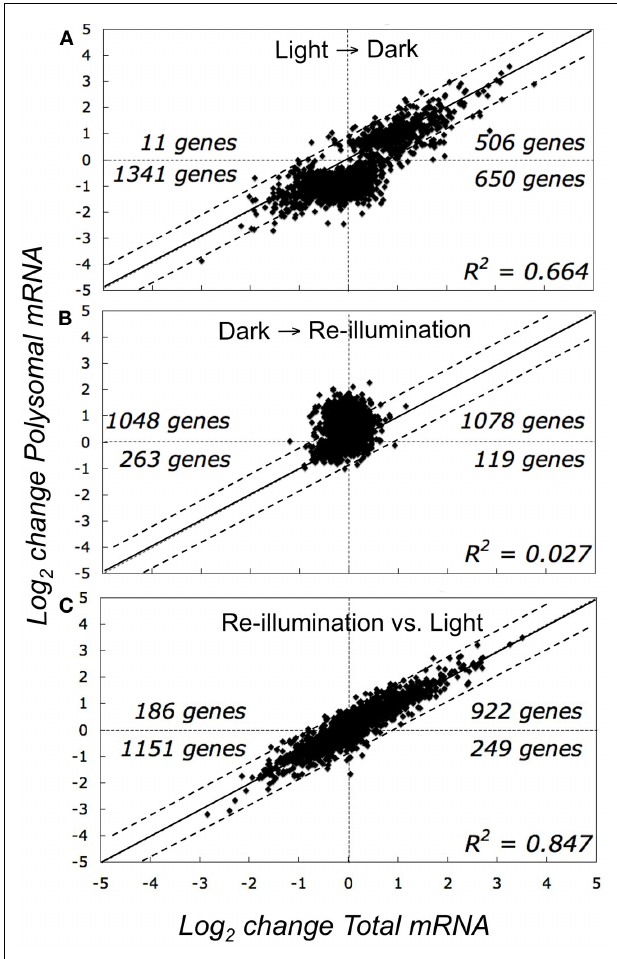
FIGURE 3 | Comparison of abundance of total and polysomal mRNA in seedlings in the light, following transfer to early darkness, and after brief re-illumination. Graphs represent the change in total steady-state mRNA abundance ( x -axis, transcriptome) versus change in immunopurified polysomal mRNA ( y -axis, translatome) (A) Comparison of seedlings in light to those shifted to darkness (Light → Dark). (B) Comparison of re- illuminated seedlings to those shifted to darkness (Dark → Re-illumination). (C) Comparison of re-illuminated seedlings versus those in light. Each point on the graphs represents the mean log 2 -transformed signal log 2 ratio (SLR) value for an individual gene by comparison of two different treatments (e.g., SLR = log 2 signalTreatment A gene i − log 2 signalTreatment B gene i), using genes without all “absent” calls in the bioreplicates and FDR < 0.05 ( n = 2508 probe pair